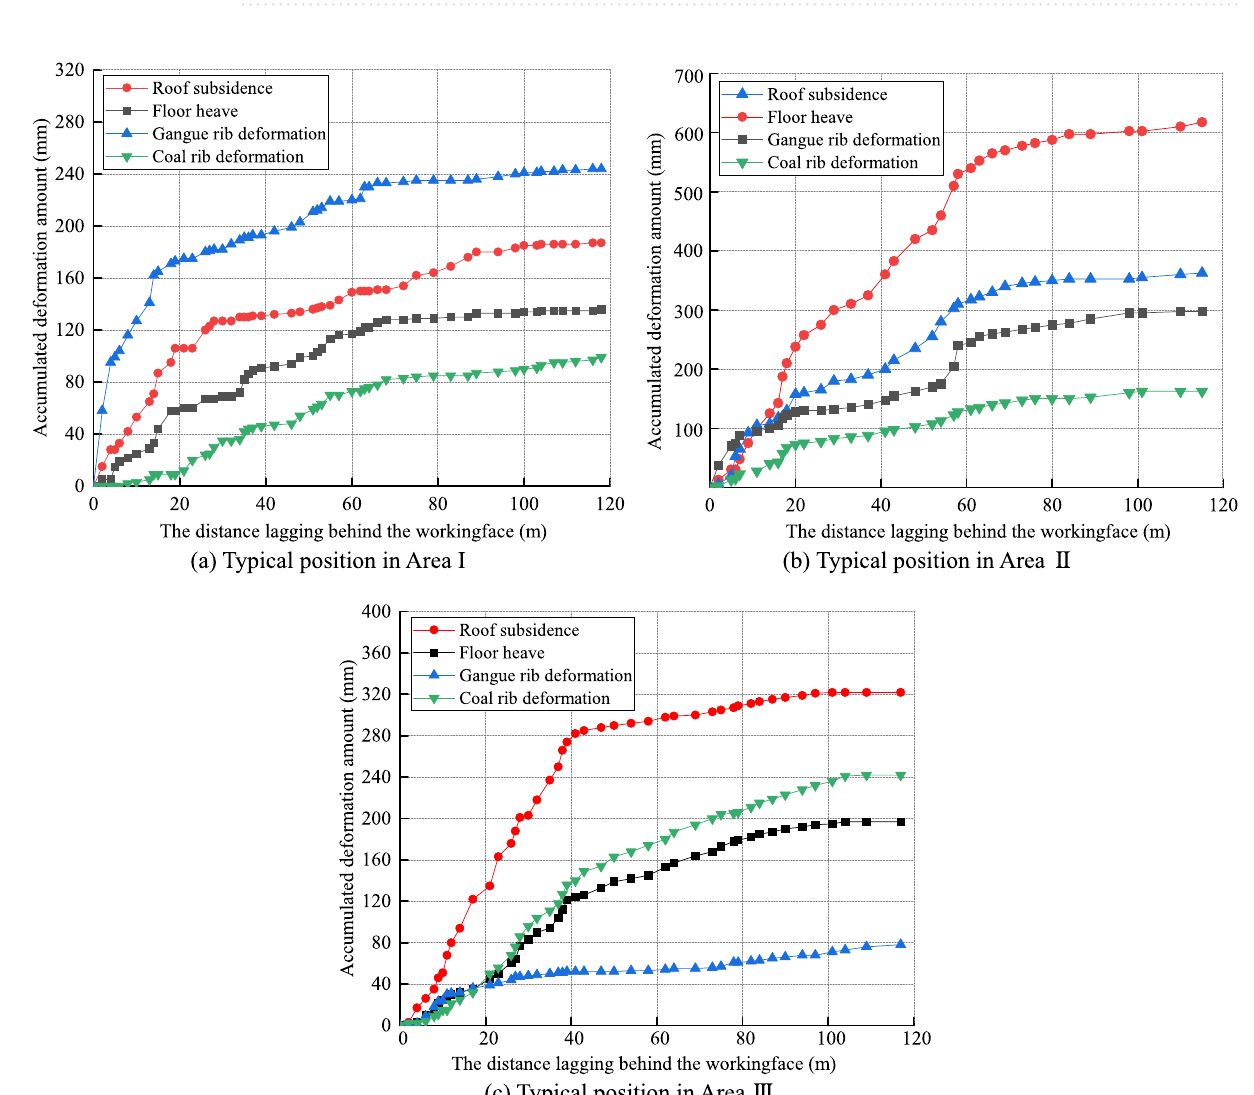
Figure 12. Statistics of the maximum and average roof loads in different test areas.